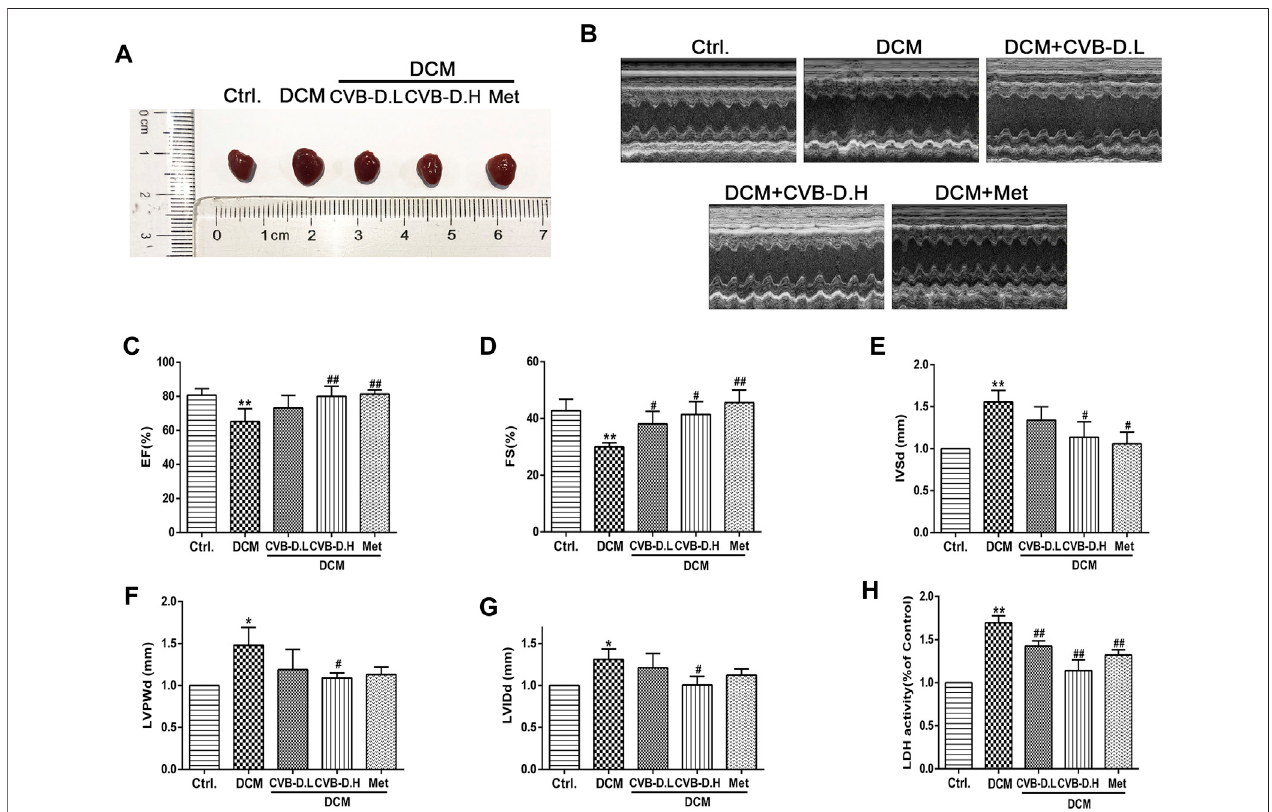
FIGURE 2 | CVB-D improves cardiac dysfunction in DCM mice. (A) Effects of CVB-D on cardiac hypertrophy in DCM mice. (B) Cardiac function of mice was measured by cardiac ultrasound. (C – G) The effect of CVB-D on EF (left ventricular ejection fraction), FS (fractional shortening), IVSd (interventricular septal thickness at diastole), LVPWd (left ventricular posterior wall dimensions), LVIDd (left ventricular internal diameter at end-diastole) of DCM mice hearts. (H) The content of LDH (lactate dehydrogenase) in serum of mice was detected. The data are presented as the mean ± SEM ( n = 6), * p < 0.05, ** p < 0.01 versus the control group; # p < 0.05, ## p < 0.01 versus the model